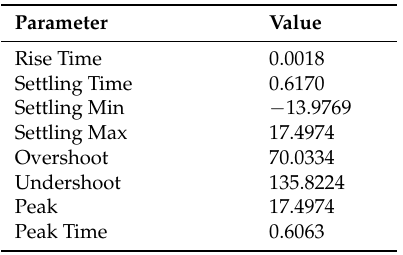
Table 9. Characteristics of the motor torque